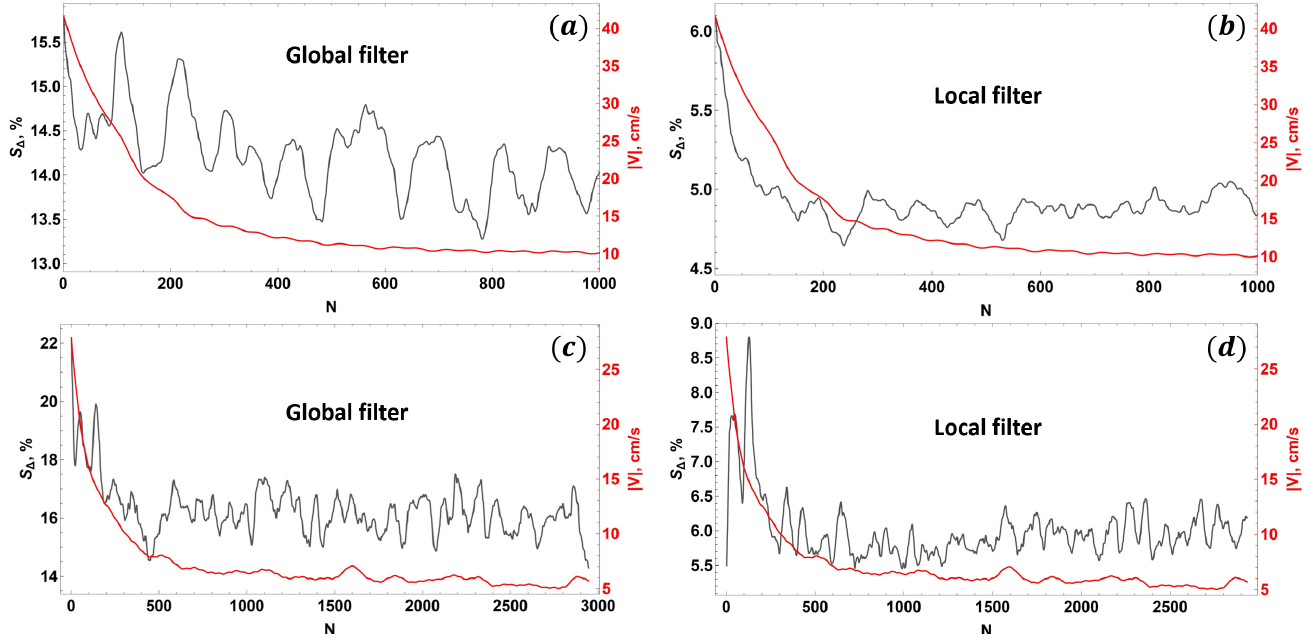
Figure 32. An illustration of the effect of body motion on the shape detection errors: examples from two image sequences. Neutron transmission along ( a , b ) the shorter and ( c , d ) longer axis of the reference body. ( a , c ) show the S ∆ dynamics over consecutive frames for the global filter and ( b , d ) show the results for the local filter. ( a , b ) show the first 1000 frames for visual clarity. Note that 3000 images were analyzed in total for both shown cases. The error time series show here are obtained from raw data by removing the outliers above and below the Gaussian TV-filtered (regularization parameter 1) q = 0.9 QSEs (3-rd order splines, (cid:98) 90% · N (cid:101) spline knots) and applying the Gaussian TV filter (regularization parameter 2) to the remaining data points. The velocity curves are as in Figure